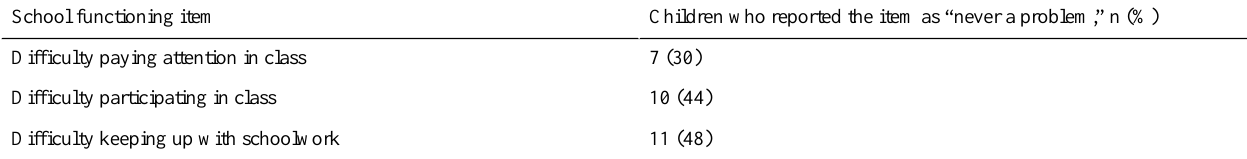
Table 6. Children’s reporting on school functioning using the Pediatric Quality of Life Inventory (n=24).